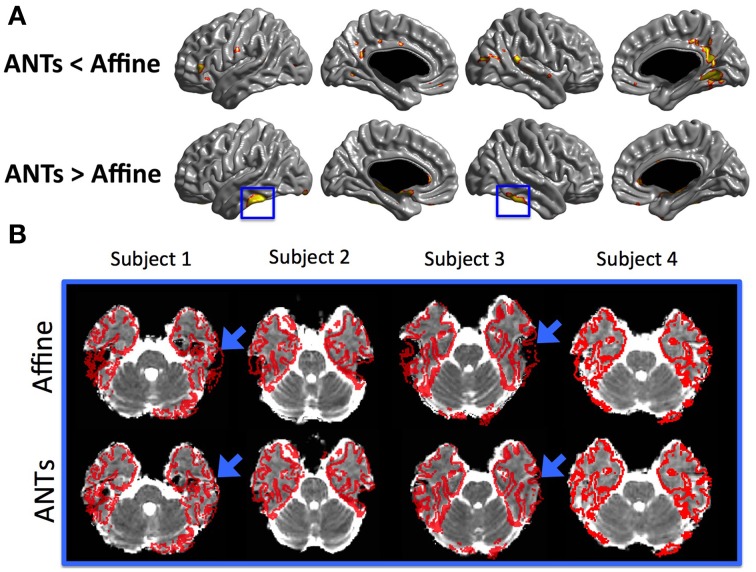
(A) Statistical maps of the differences in MD values between the SGDM with ANTs-SyN and the SGDM with affine registration. The color scale on the bottom represents the multiple comparison corrected p < 0.05. (B) The cortical surface superimposed in the MD volume. The MD volume was aligned to T1-wighted volume space using affine registration and ANTs-SyN registration. We choose the 4 subjects. The blue rectangles in (A) correspond to the location of blue arrow in (B).